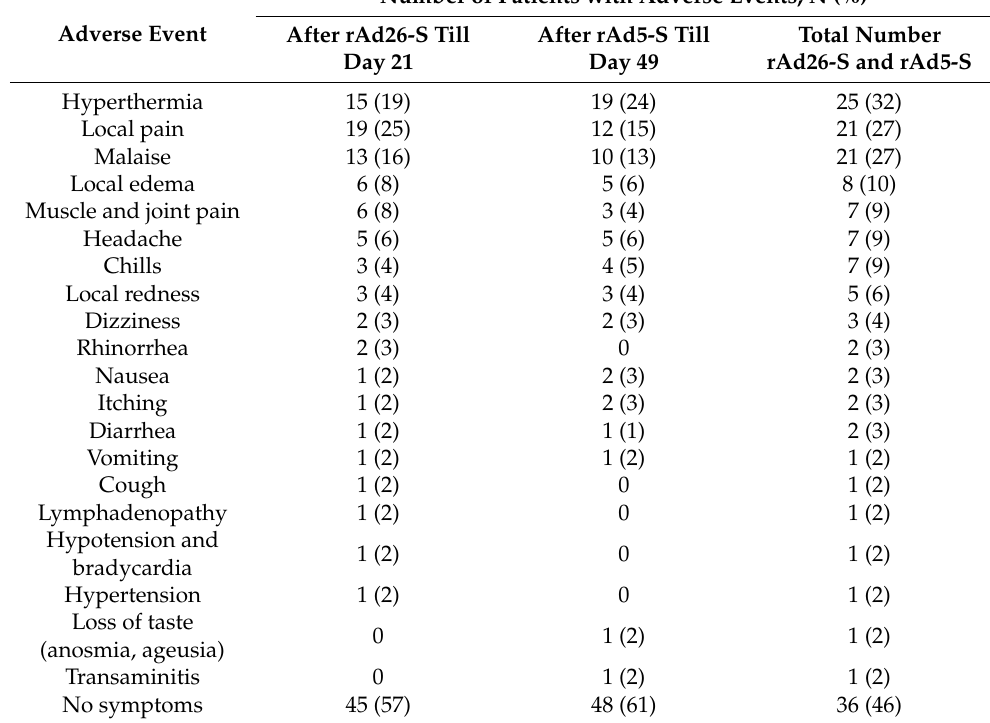
Table 2. Adverse events in patients with